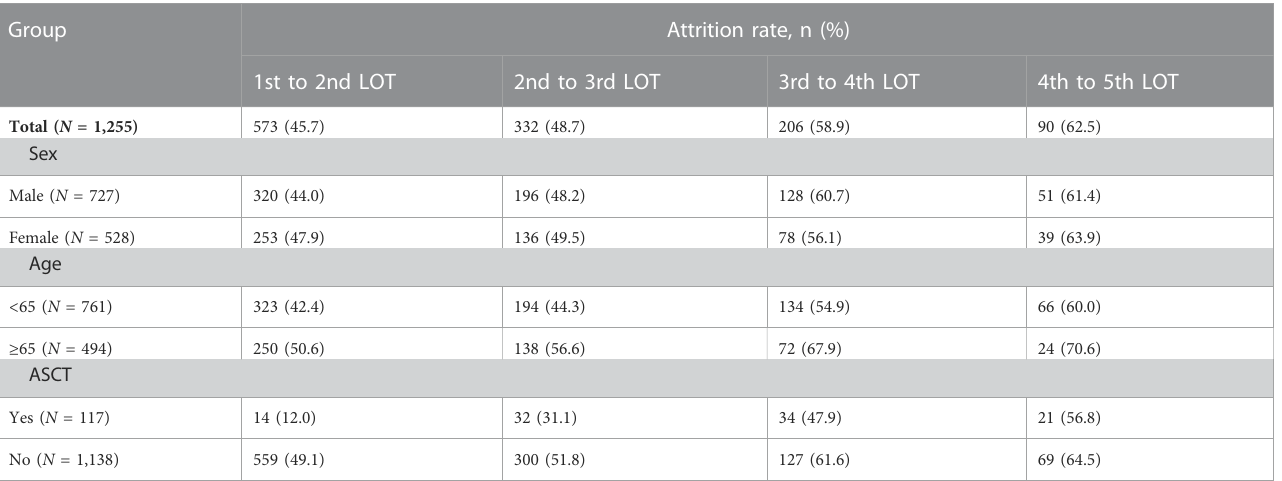
TABLE 2 Attrition rates between distinct LOTs in speci fi c clinical settings.